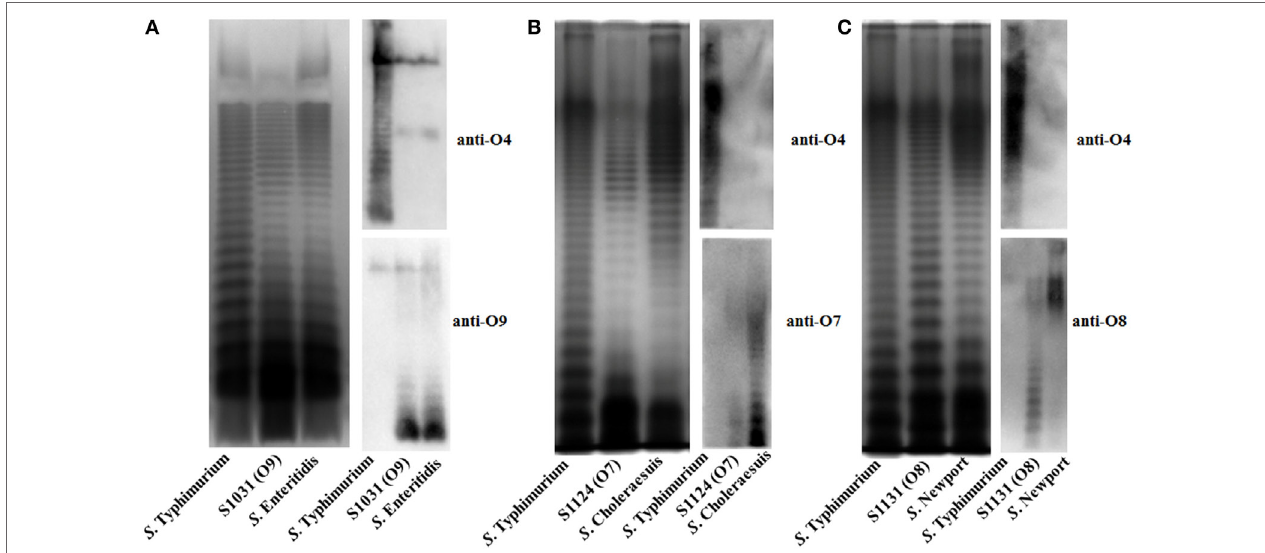
FigUre 2 | LPS profiles of O-serotype-converted mutants. (a) The LPS profiles of wild-type Salmonella Typhimurium, S . Enteritidis. and S1031 (O9) were compared. The O-serotype of S1031 was confirmed by incubation with Salmonella D1 serogroup-characterized O9 single-factor antisera, as indicated. (B) The LPS profiles of wild-type S . Typhimurium, S . Choleraesuis, and S1124 (O7) were compared. The O-serotype of S1124 was confirmed by incubation with Salmonella C1 serogroup-characterized O7 single-factor antisera, as indicated. (c) The LPS profiles of wild-type S . Typhimurium, S . Newport, and S1131 (O8) were compared. The O-serotype of S1131 was confirmed by incubation with Salmonella C2 serogroup-characterized O8 single-factor antisera, as